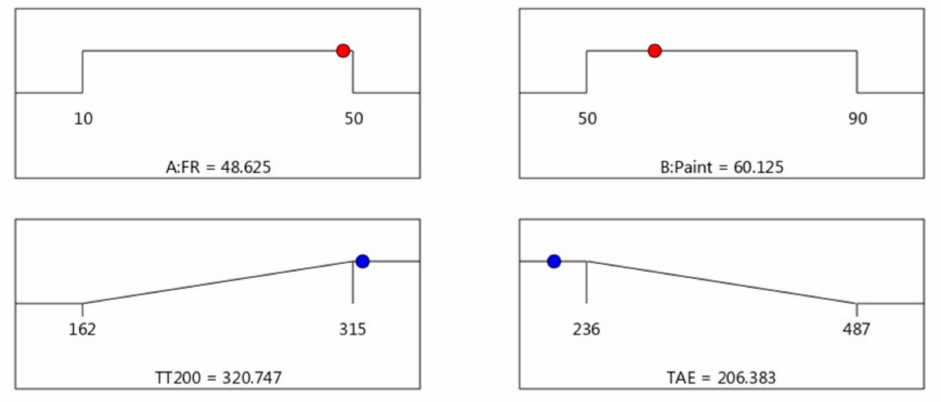
Figure 5. Optimum conditions and response for thermal properties.